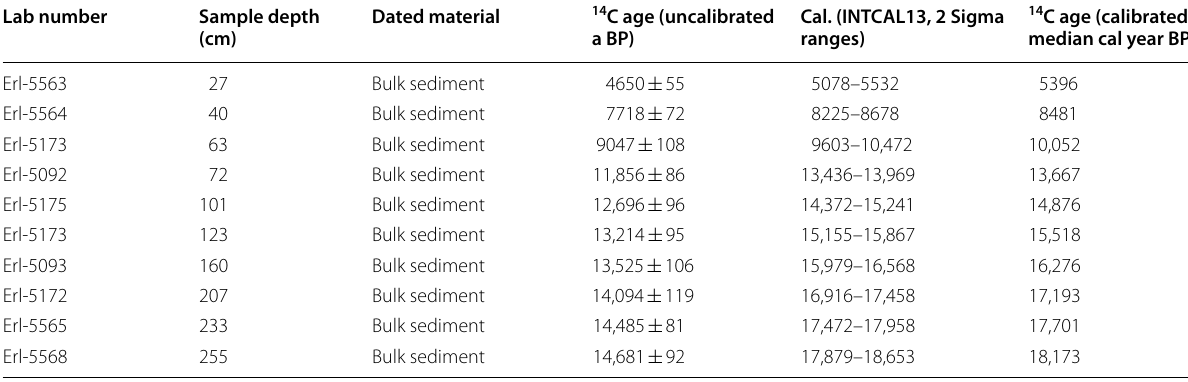
Table 1 Radiocarbon ages using Accelerated Mass Spectrometry of alkali soluble organic matter; calibrated according to Blaauw and Christen